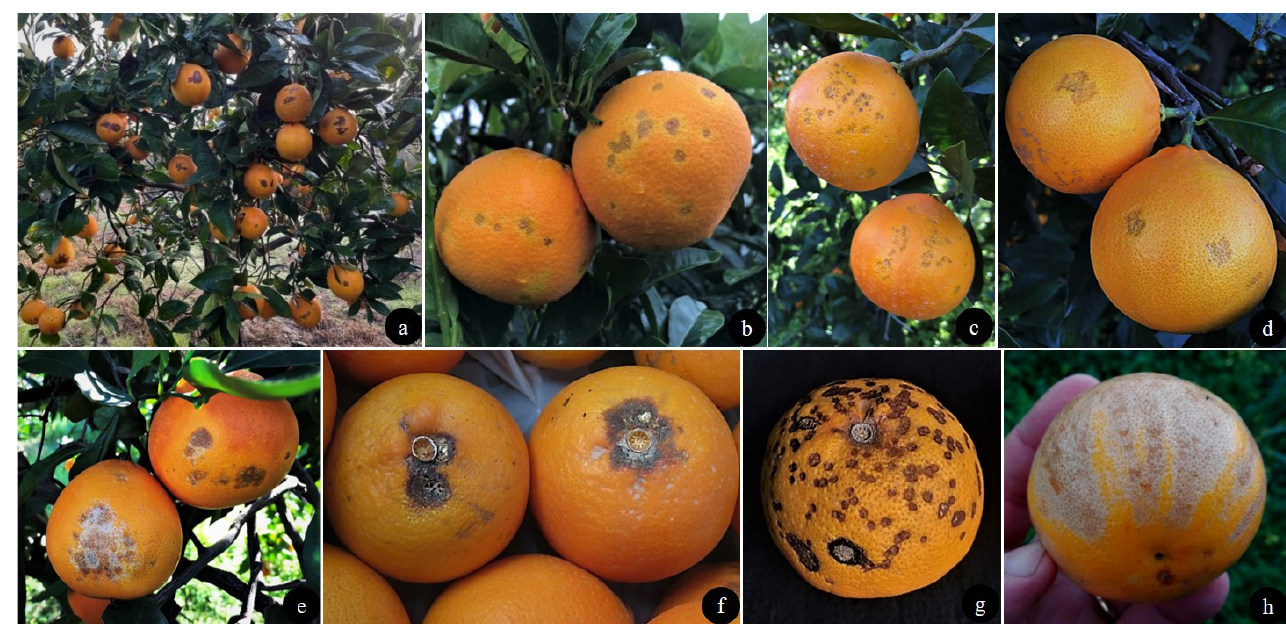
Figure 4. Pre-harvest anthracnose on fruit: ( a ) severe anthracnose fruit spot on “Tarocco Scirè VCR”; ( b – e ) small to large light, irregular and sunken lesions that could turn to black and formed acervuli on “Tarocco” blood orange accessions. ( f ) necrotic lesions at the stem-end of fruit that can cause pre-harvest fruit drop; ( g ) circular, small, necrotic lesions on “Tarocco Emanuele”; ( h ) tear stain on “Tarocco Sciara” fruit.